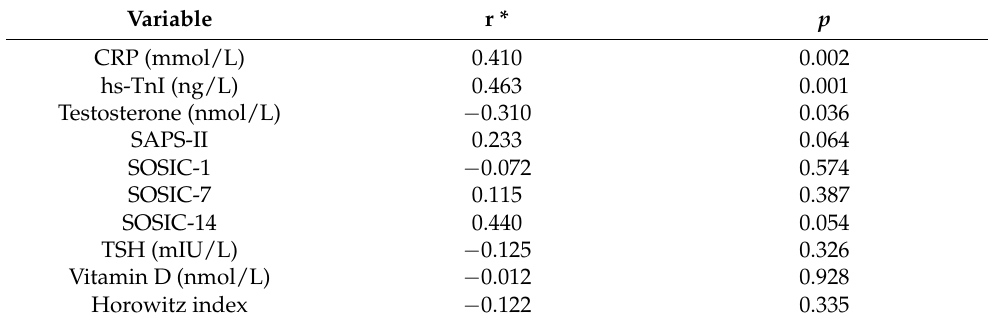
Table 3. Correlation between serum TWEAK levels at admission to ICU and variables of interest.